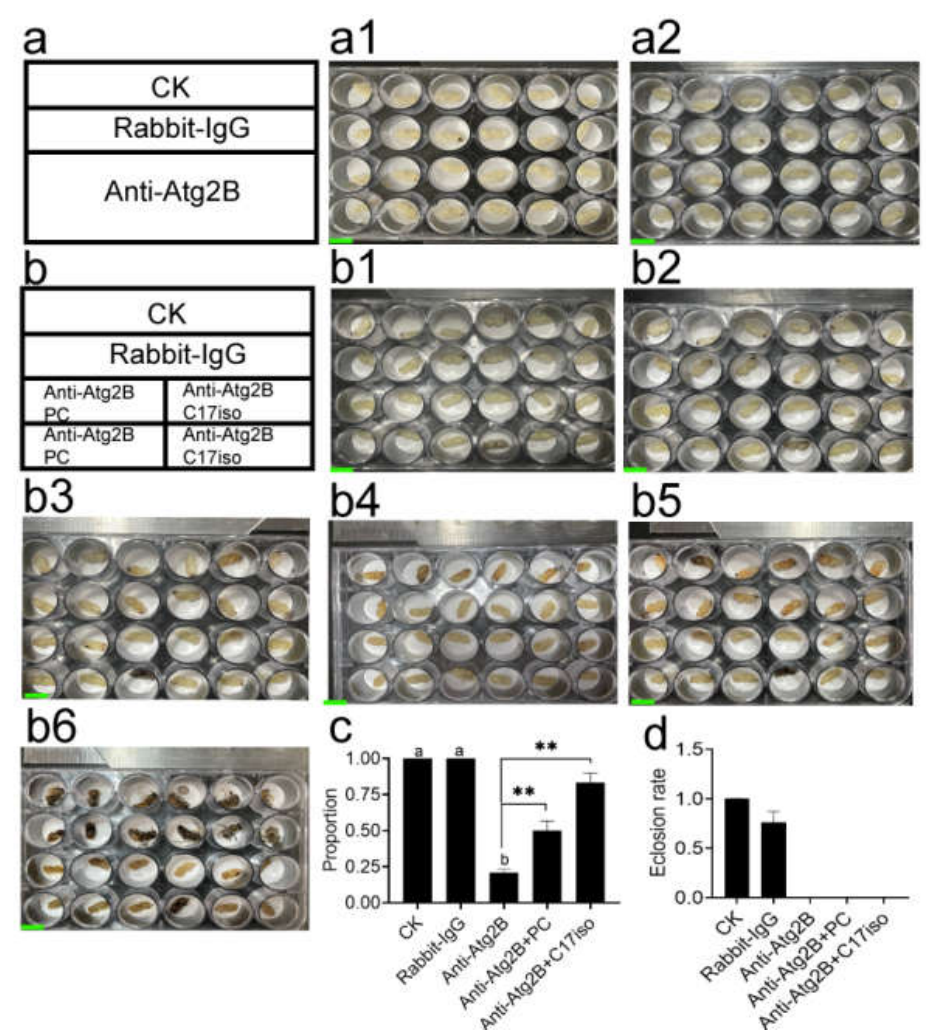
Figure 7. The developmental arrest of Anti-Atg2B-induced pupae is partially rescued by injecting PC or C17iso. ( a ) The first two days (a1–a2) developmental progression of pupae after the injection of Anti-Atg2B antibodies or IgG and CK. ( b ) Schematic description of PC or C17iso rescuing experiments, and the continuous growth recording until emergence in CK ( b1 – b6 ). Scale bar: 1 cm. ( c ) Growth arrest of Anti-Atg2B-induced pupae could be partially rescued into Pp by injecting PC or C17iso. ( d ) Percentage of eclosion in rescued group, IgG and CK. Note: Data are shown as mean ± SEM and the different letters marked on the bar chart represent significant differences ( p < 0.05), ** ( p < 0.01).